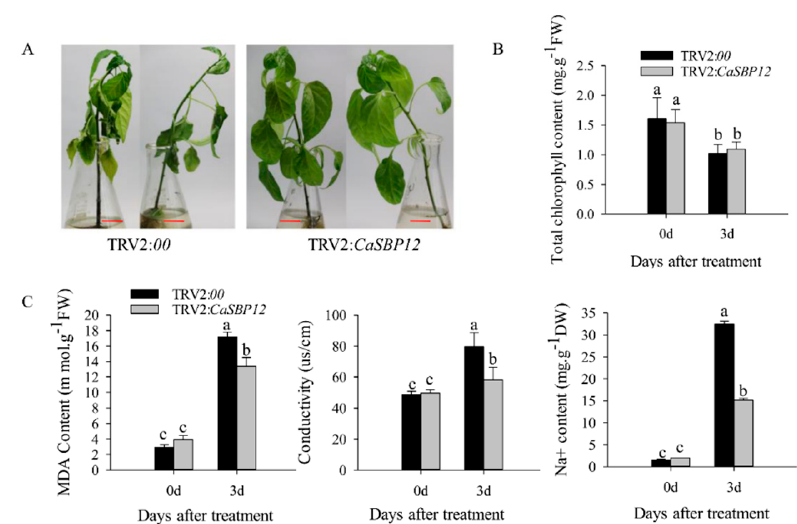
Figure 4. Phenotypes, total chlorophyll, Na + , malondialdehyde (MDA) content and conductivity of silenced plants after 3 days of salt stress. ( A ) Phenotypes of CaSBP12-silenced and control plants after 3 days of treatment with 400 mM NaCl. The red line is used as a scale bar (length 2 cm). ( B ) The total chlorophyll content of CaSBP12-silenced and control plants after 3 days of treatment with 400 mM NaCl. ( C ) The Na + , MDA content, and conductivity of CaSBP12-silenced and control plants after 3 days of treatment with 400 mM NaCl. d: days. Bars with different letters indicate significant differences at p ≤ 0.05. Mean values and SDs for three biological replicates are shown.